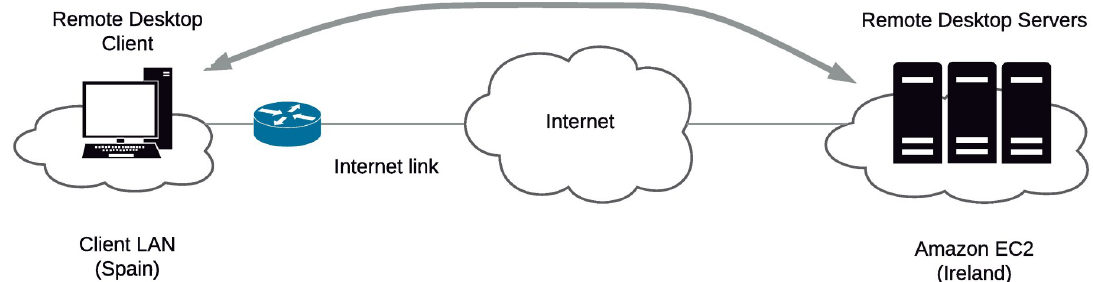
Fig 1. Experimental scenario for evaluation of RD